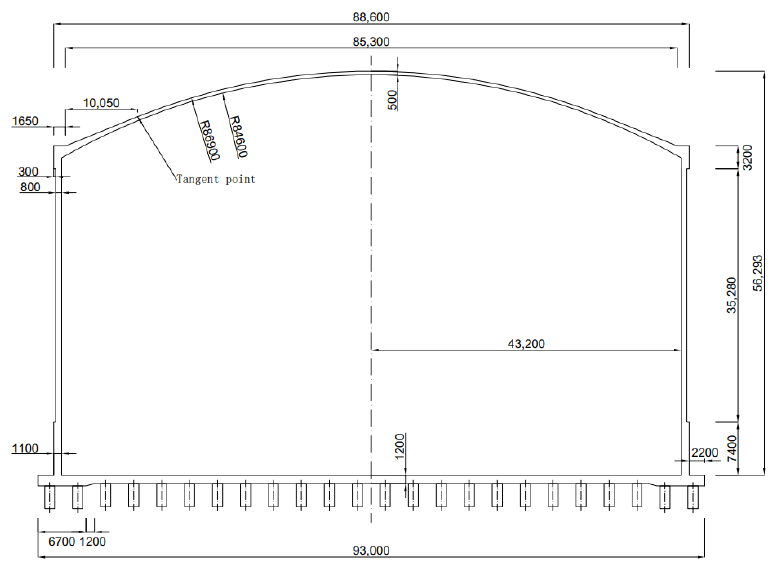
15 of 21 Figure 10. Comparison results of the isolation storage tank under El Centro (X, 0.5 g): ( a ) measuring point 11; ( b ) measuring point 11; ( c ) measuring point 12; ( d ) measuring point 13. Based on the numerical simulation analysis of the test tank, it can be confirmed that the seismic response of the numerical simulation results is close to that of the test results, and the fitting degree of their spectral characteristic curves is also very good, which veri- fies the rationality and effectiveness of the numerical model. The numerical model of this paper can be used for seismic response analysis of large LNG storage tanks. 4. Numerical Simulation Analysis of Large LNG Storage Tank